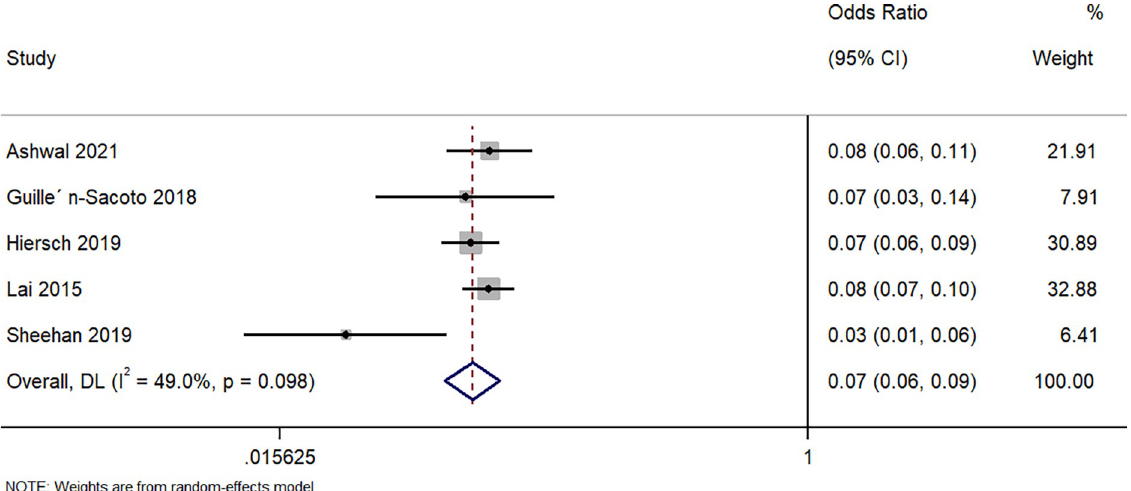
Fig 6. Forest plot showing the difference in preterm delivery between women with a singleton pregnancy or twin pregnancy and GDM. NOTE: Weights are from random-effects model.